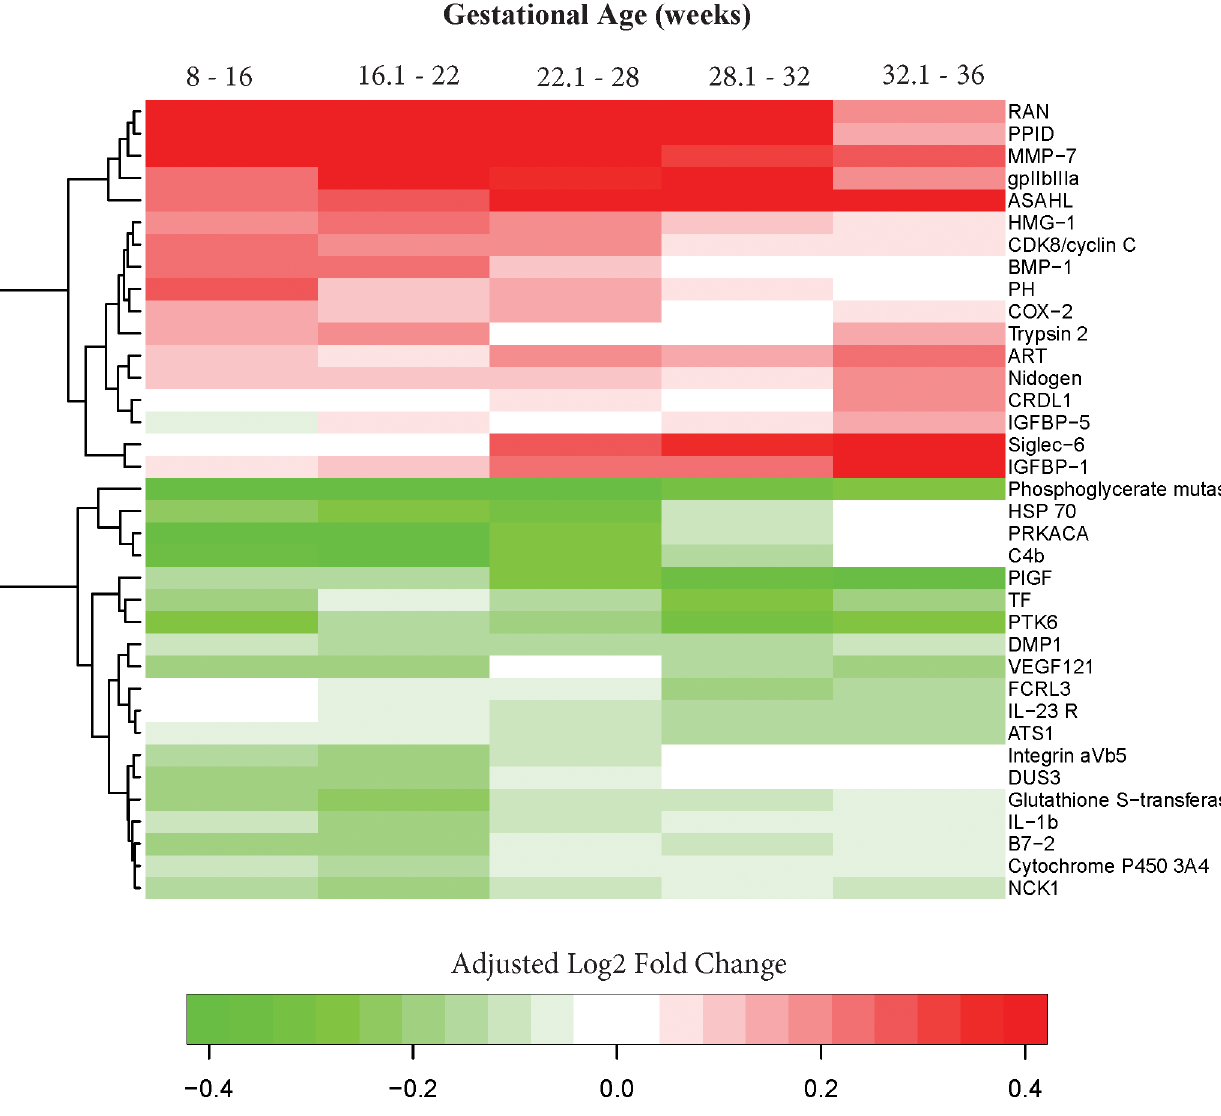
Fig 5. A summaryof differential protein abundance between late-onset preeclampsia and normal pregnancy throughout gestation. The value shown using a color scheme representsthe log 2 fold-change in MoM values betweencases and controls (green = lower, red = highermean MoM in cases than in controls). Absolute fold-changes > 1.3 (absolutelog2 fold change > 0.4) were re-set to 1.3 in order to enhancevisualizationof the data.